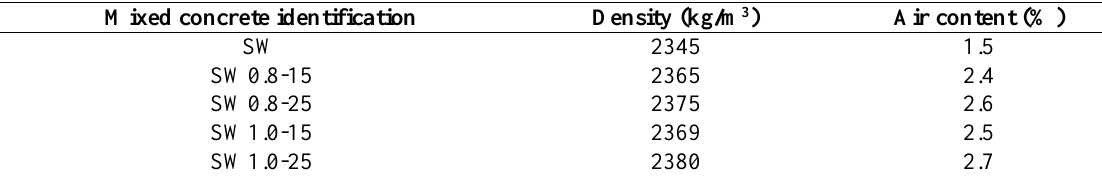
Table 4. Fresh characteristics of the mixed